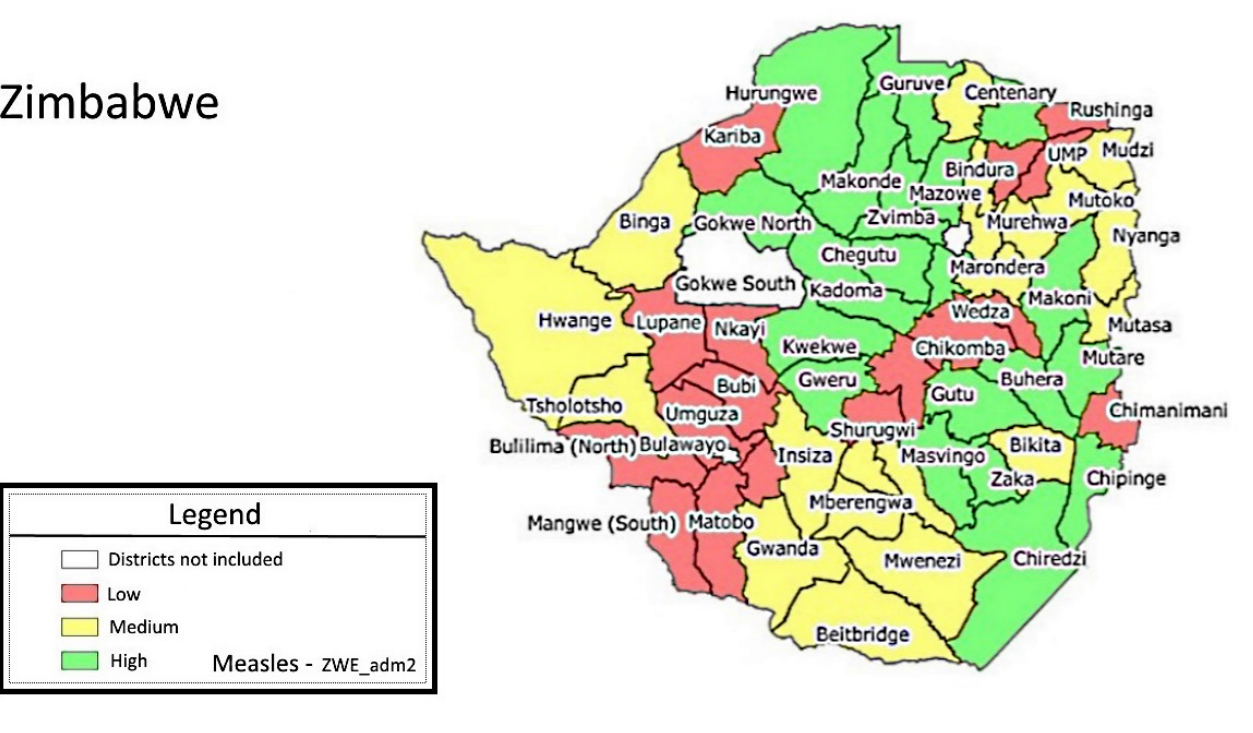
Figure 1a-1d. Immunisation Domain Clustering Using Heatmap Technique Figure 1a. Measles Coverage